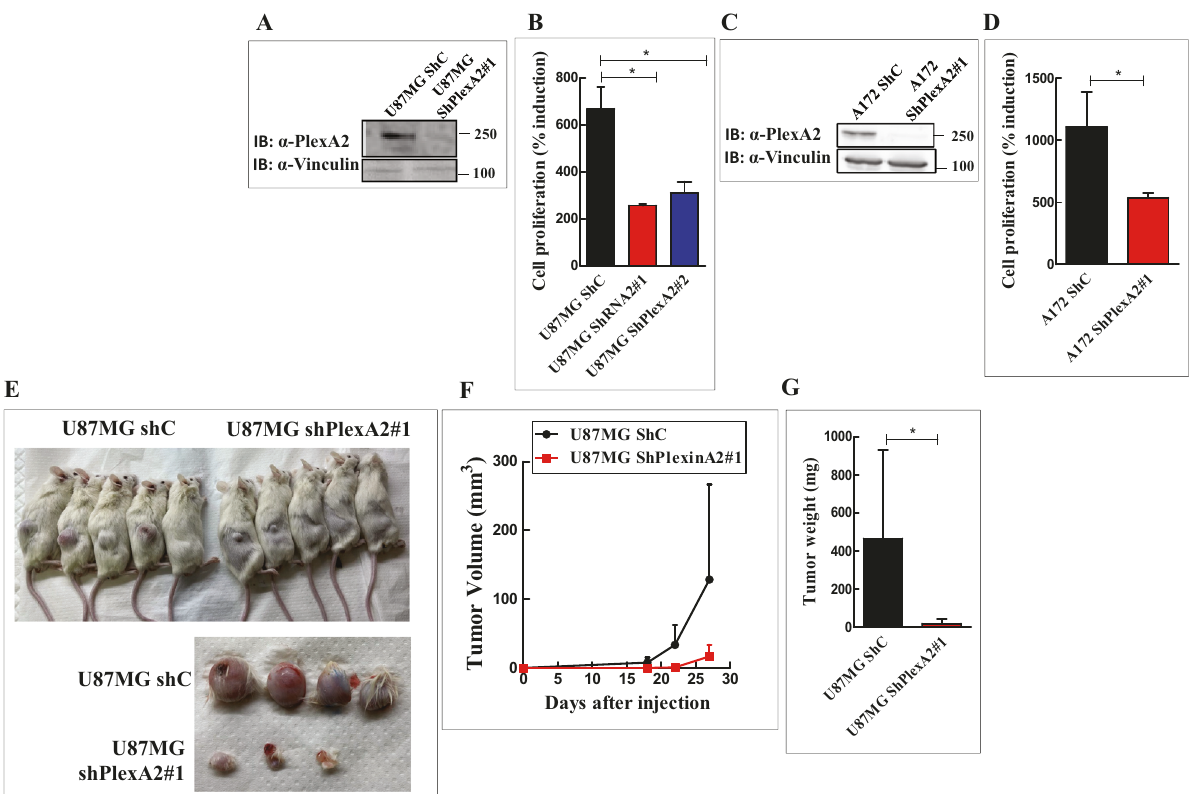
Fig. 1 Silencing plexin-A2 expression in U87MG and A172 cells inhibits their proliferation and the development of subcutaneous tumors. A Western blot showing plexin-A2 expression levels in U87MG cells expressing a non-speci fi c shRNA (ShC) or a shRNA targeting plexin-A2 (ShPlexA2#1). Cell lysates were probed with antibodies directed against plexin-A2 or vinculin. B U87MG or U87MG cells silenced for plexin-A2 expression using two different shRNAs were seeded in triplicate (2 × 10 4 cells/well) in 24 well dishes. Cells were counted in a coulter counter after 3 days. Shown is the percentage of attached cells on day 3 compared with the number of cells attached on day 0 which was taken as 100%. Data are represented as mean ± SD. Statistical analysis was done using the one tailed Mann-Whitney test. * P < 0.05, N = 3. C Western blot showing plexin-A2 expression levels in A172 cells expressing a non-speci fi c shRNA (ShC) or a shRNA targeting plexin-A2 (ShPlexA2#1). Cell lysates were probed with antibodies directed against plexin-A2 or vinculin. D A172 cells were infected with lentiviruses encoding a control shRNA (ShC) or a shRNA targeting plexinA2 (ShPlexA2#1). Each group of cells was seeded in quadruplicate in 96 well dishes (3 × 10 3 cells/well). Cell proliferation was measured using the WST-1 proliferation assay as described in materials and methods, and the